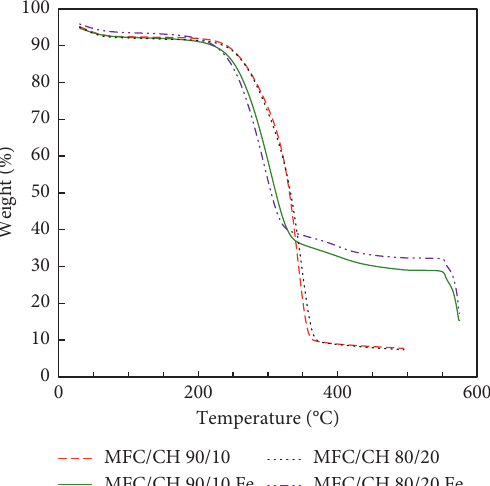
Figure 6: TGA profilesofMFCcryogels withandwithoutMNPloading(underthe N